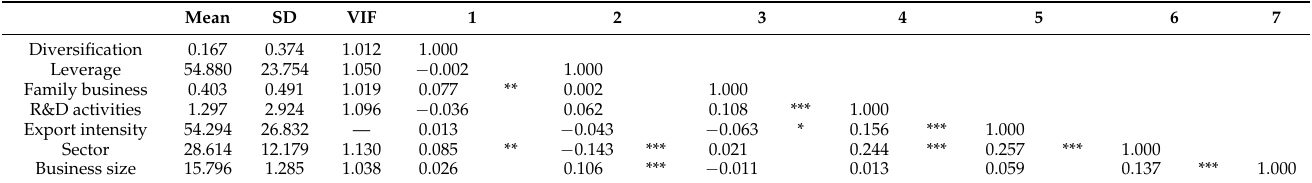
Table 2. Descriptive statistics and Correlation Matrix. Early